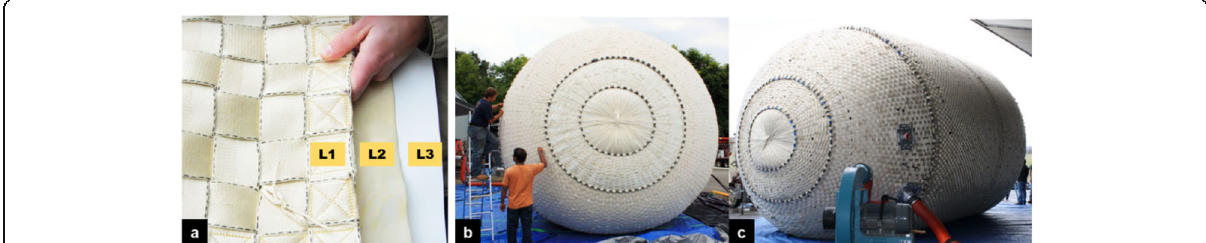
Fig. 6 Phase 2b. a Three-layer membrane configuration comprised of Vectran woven webbing (L1), protective Vectran fabric layer (L2), and inner bladder layer of urethane-coated polyester (L3). Unconfined inflation of ( b ) full-scale three-layer surrogate plug; ( c ) full-scale three-layer Vectran plug [44, 87, 88]